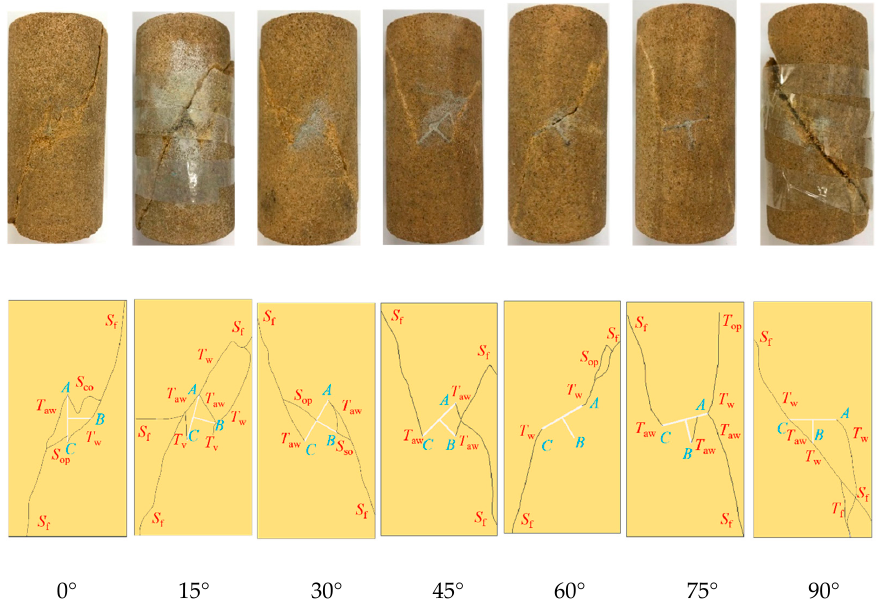
Figure 9. Failure mode of sandstone with T-shaped fractures.